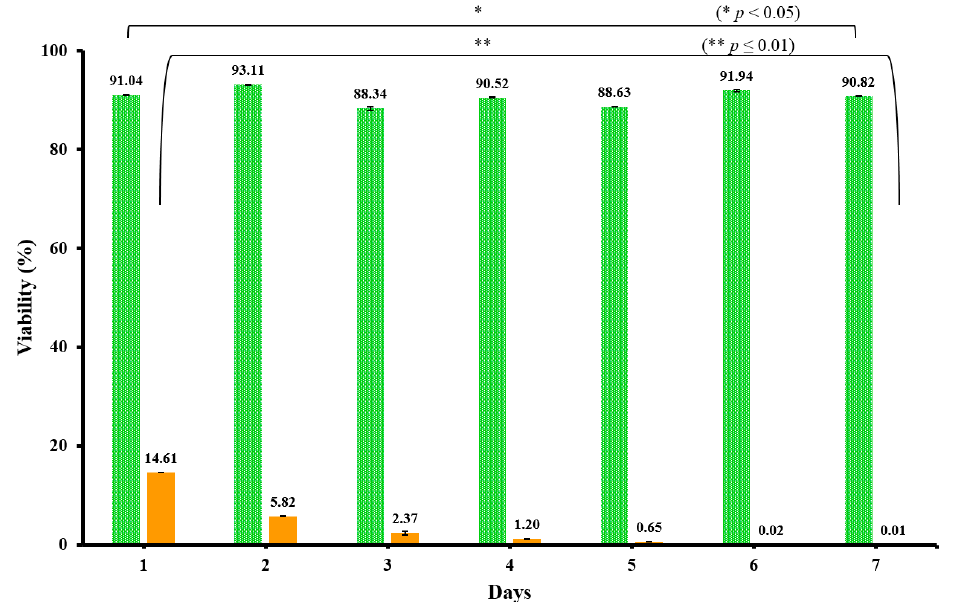
Figure 5. Cytotoxicity (MTT) analysis of the CH–GE–PEG (green) cell-laden 3D constructs with untreated cells as the negative control and Triton-X − 100 (orange) as the toxic positive control ( n = 3, ±SD). Differences between experimental data were considered as statistically significant. * = p < 0.05; ** = p ≤ 0.01.